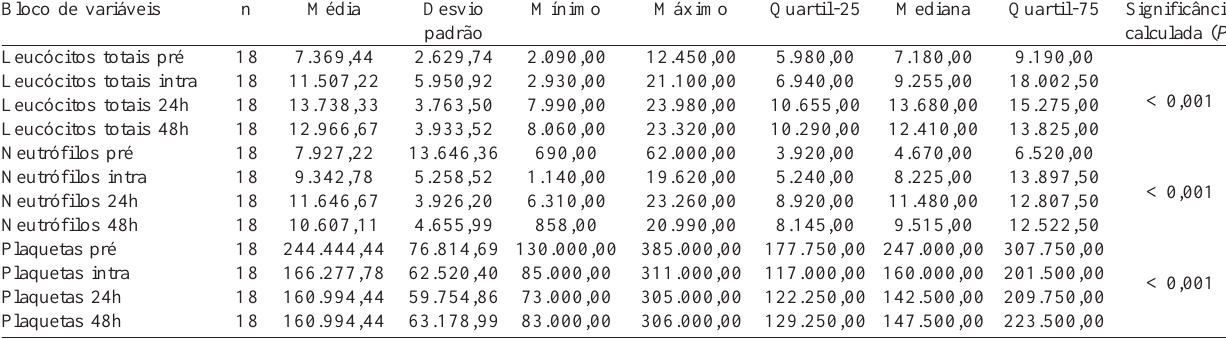
Bloco de variáveis